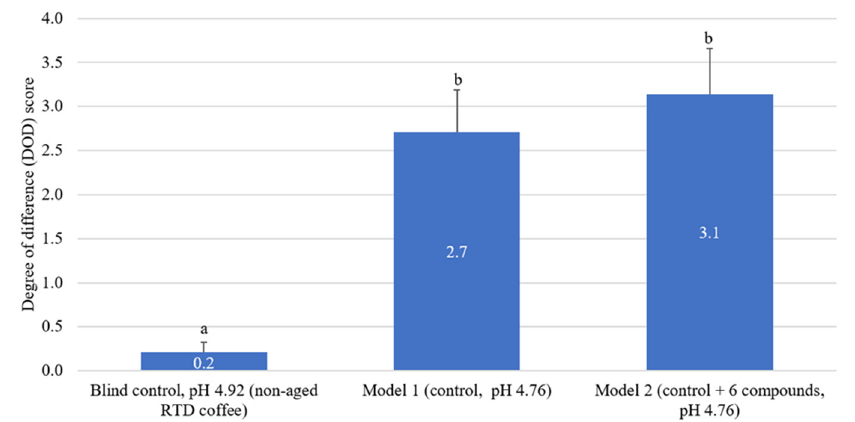
Figure 3. Mean degree of difference (DOD) scores with standard error for blind control and recombi- nation model 1 (control, pH adjusted) and model 2 (control, pH adjusted with the addition of 81.5, 58.5, 44.3, 18.5, 9.3, and 168.9 mg/L of 3-caffeoylquinic acid, 5-caffeoylquinic acid, 4-caffeoylquinic acid, 3-O-feruloylquinic acid, 4-O-feruloylquinic acid and quinic acid, respectively); different letters represent significant differences in DOD scores according to 1-sided Dunnett’s test ( p < 0.05); n = 14, DOD scores ranged from 0–10.